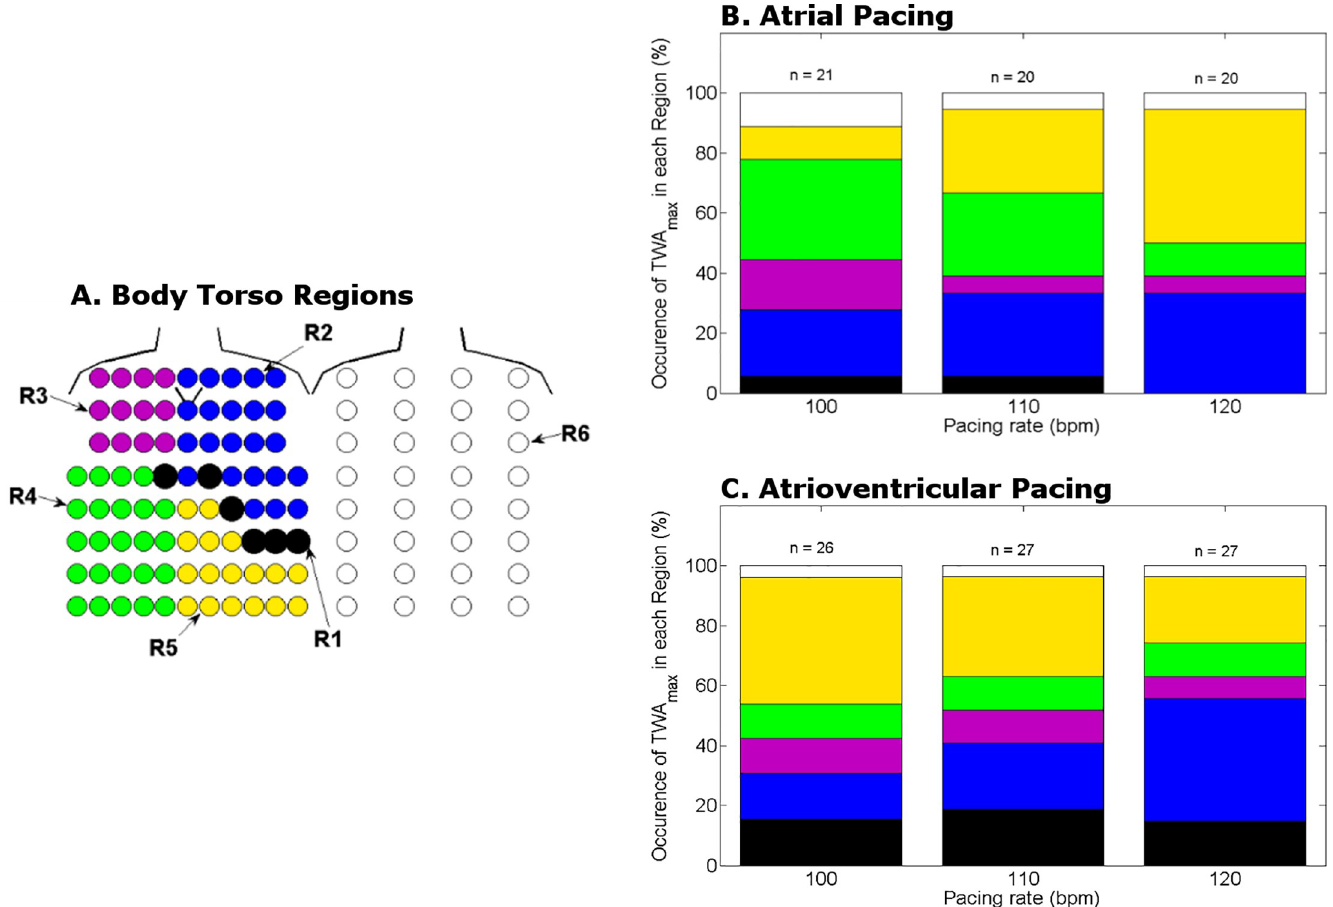
Fig 3. Body torso distribution of TWA max during atrial and atrioventricular pacing. The body torso was divided into 6 regions ( A ). R1 indicates the location of the standard precordial leads, V1-V6. R6 is the posterior chest. With increasing atrial pacing rate, TWA max shifted from R4 to R5 ( B ). With increasing atrioventricular pacing rate, TWA max relocated from R5 to R2 ( C ).